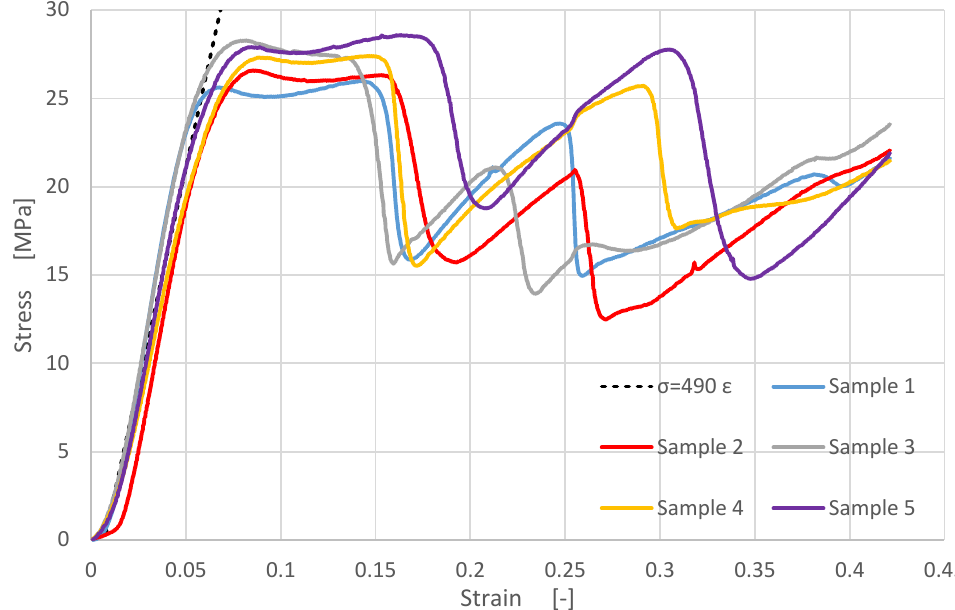
Figure 9. Experimental results for horizontally layered printed samples: engineering compressive stress versus compressive strain.